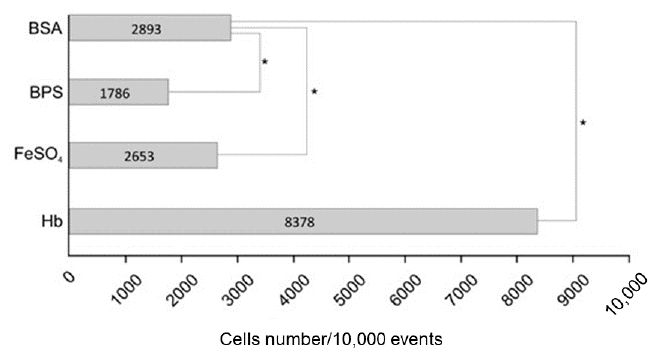
Figure 2. P. lutzii interaction with macrophages assessed by flow cytometry. P. lutzii yeast cells were grown in the presence of BPS, hemoglobin or FeSO 4 and incubated for 4 h with RAW 264.7 macrophages. BSA was used as control. Methanol fixed, non-permeabilized cells were incubated with 100 µ g/mL of Congo Red. The amount of P. lutzii cells that interacted with macrophages was assessed by flow cytometry using the instrument Guava ® easyCyte (MERK). Proportion test was used for statistical comparison between the conditions analyzed. (*) denotes a statistically significant